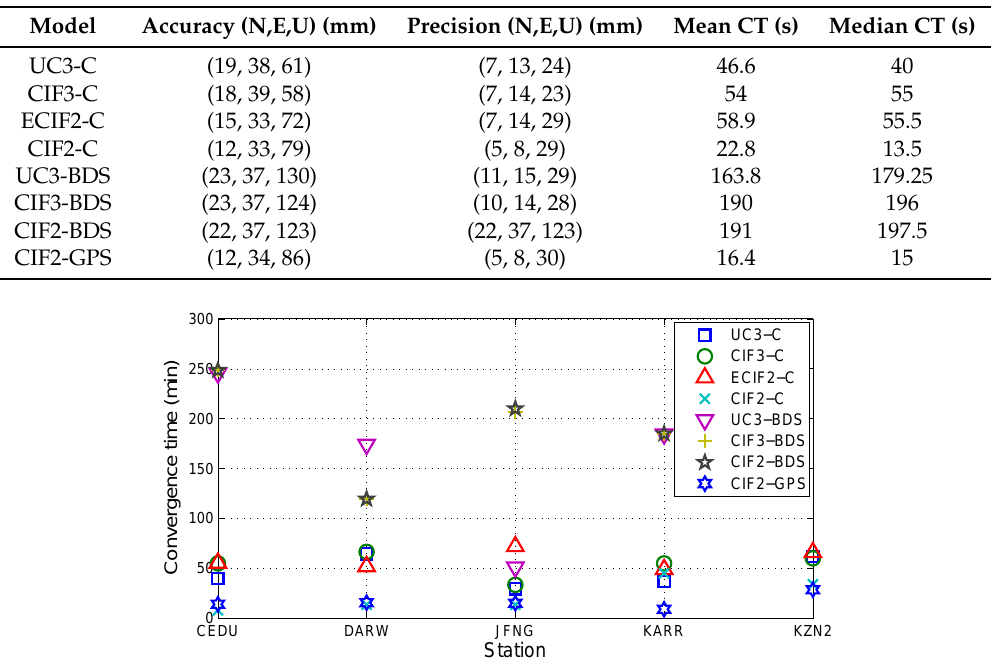
Figure 11. The convergence time for different combined models at different